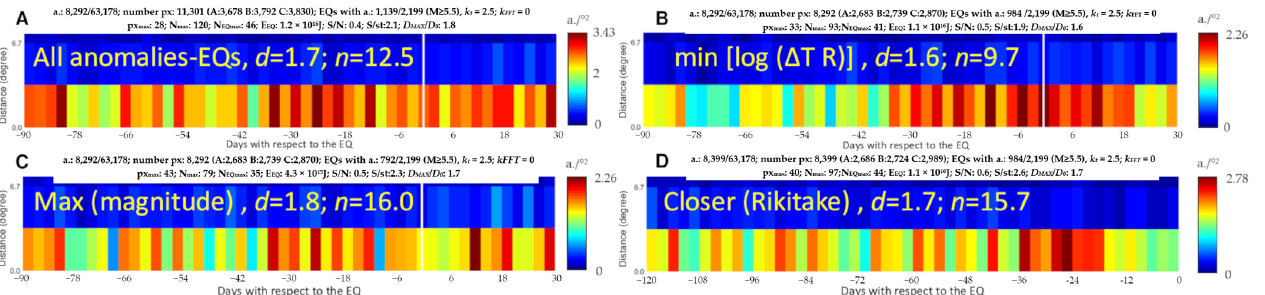
and it is also indicated in the first line of the heading of the graph as the second number